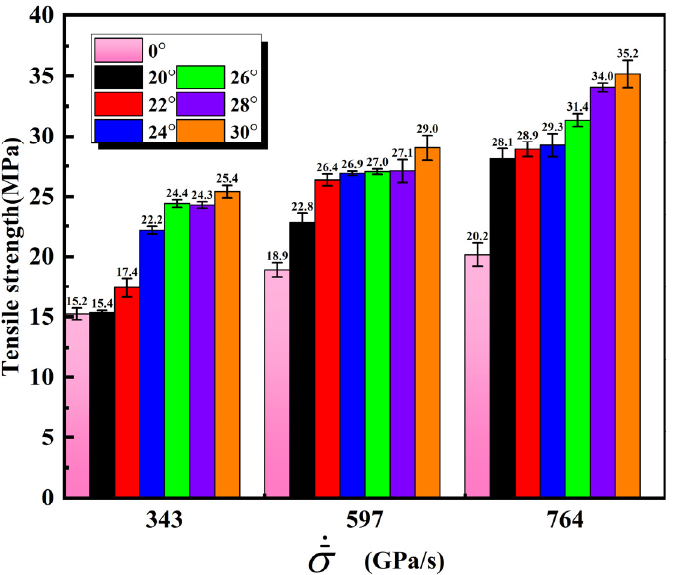
Figure 17. Relationship between dynamic tensile strength and loading